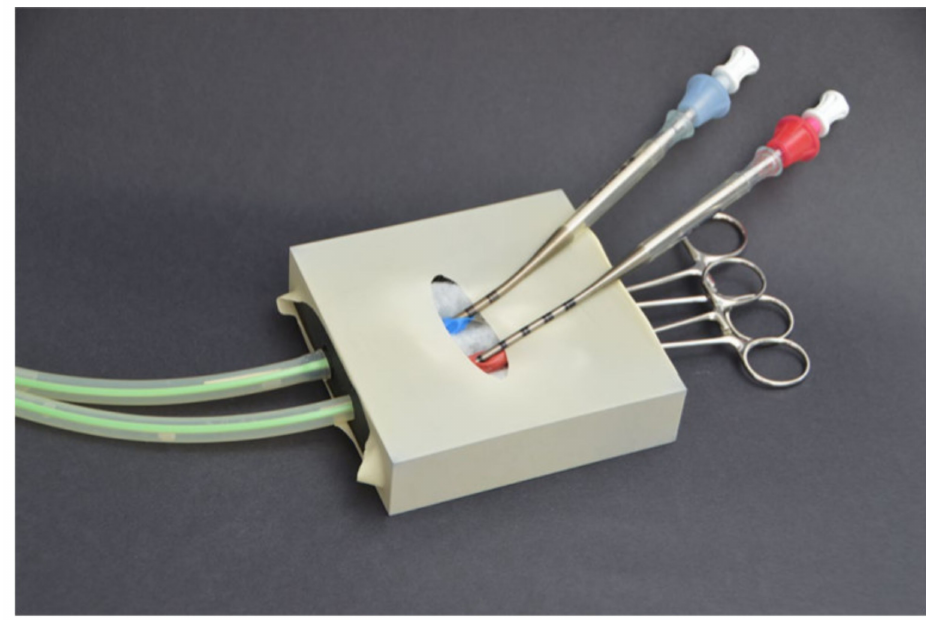
Figure 10. Cannulation access point simulator